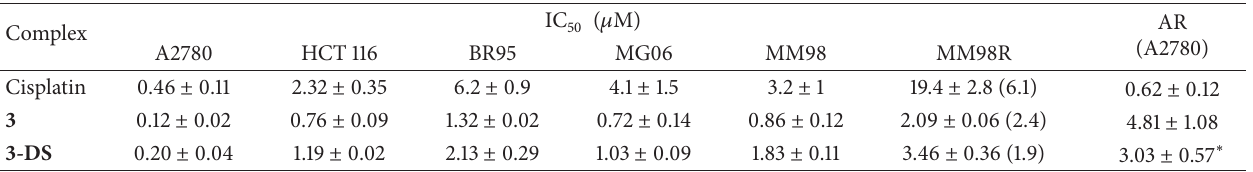
Table 1: Antiproliferative activity (IC 50 values, 𝜇 M) after 72 h continuous treatment and cellular accumulation (AR, 4h, 10 𝜇 M) of cisplatin, complex 3 , and its conjugate 3-DS .